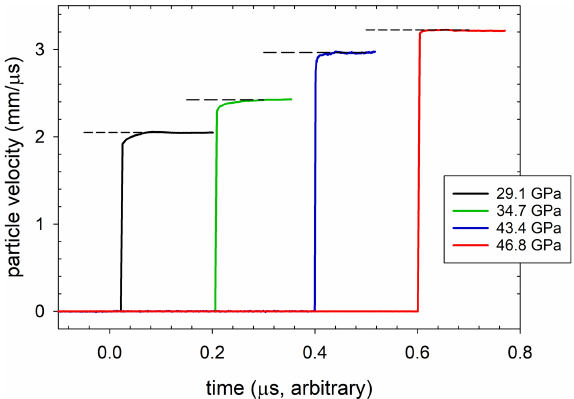
Figure 14. Transmitted particle velocity wave profiles measured at the windowed sample/LiF interface in selected top-hat experiments performed on the CE composite. The profiles span pressures from 29.1 to 46.8 GPa. Average interface particle velocities for each experiment are indicated in the Figure by the dashed lines. (reprinted with permission)